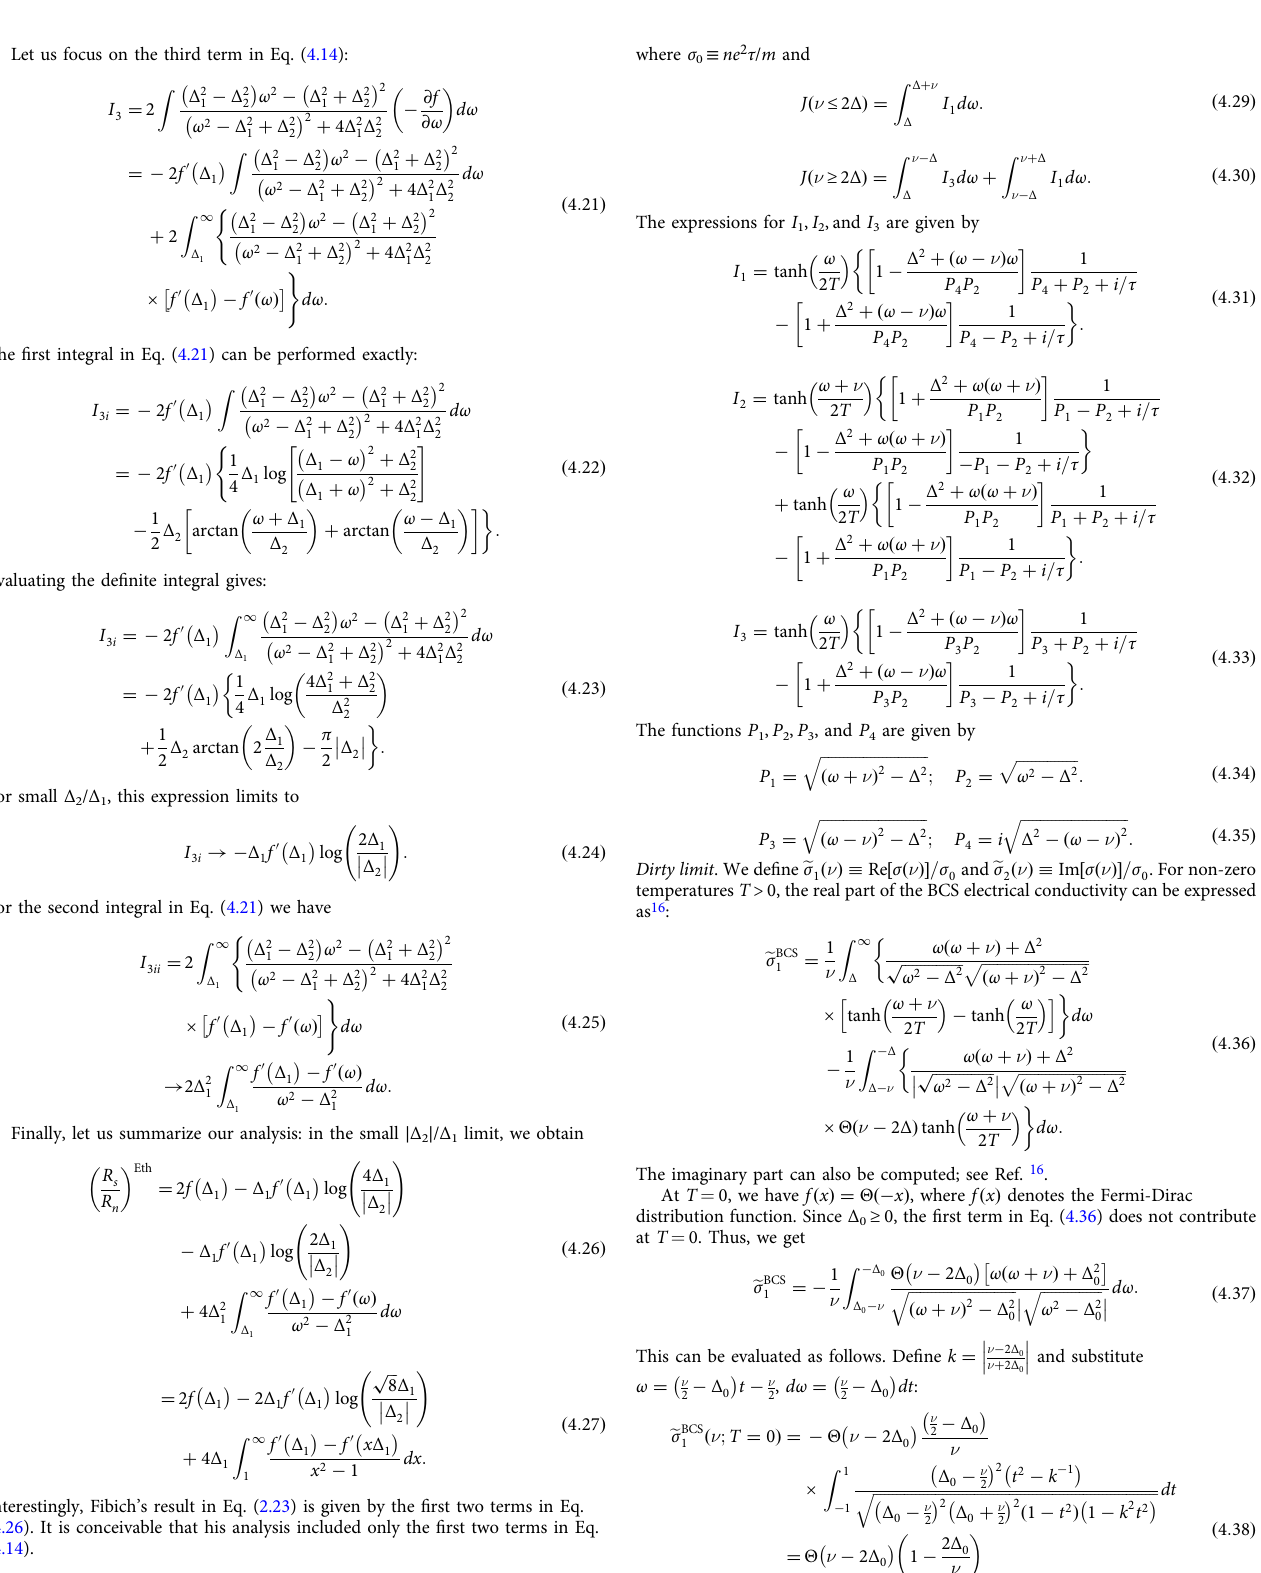
1 ffiffiffiffiffiffiffiffiffiffiffiffi ffiffiffiffiffiffiffiffiffiffiffiffiffiffiffiffi 1 (cid:1) k 2 t 2